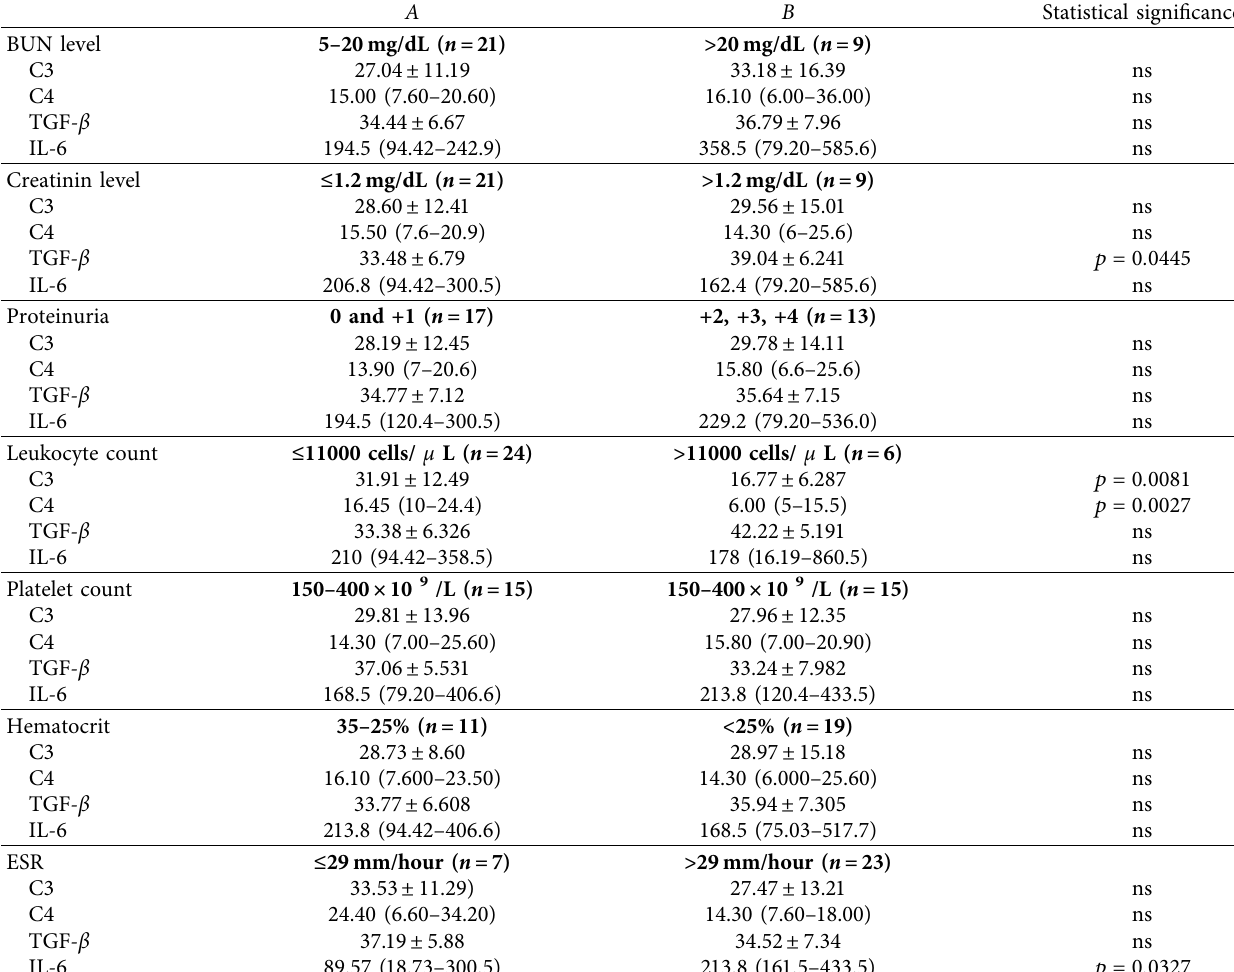
Table 3: Association of complement and cytokine levels with renal damage and hematological activity.